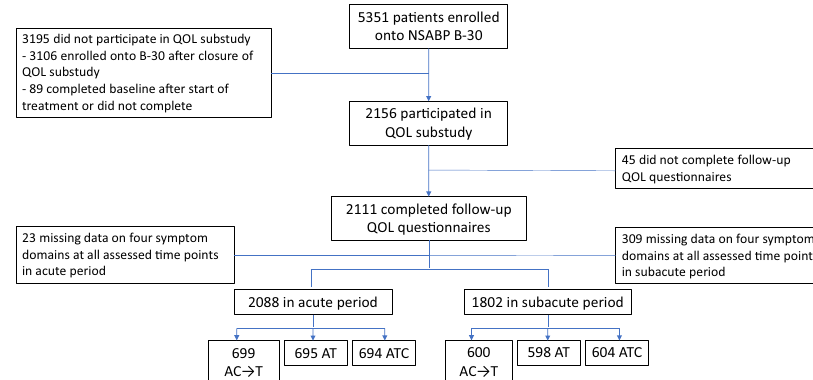
Fig. 1 CONSORT diagram. A doxorubicin, C cyclophosphamide, QOL quality of life, T